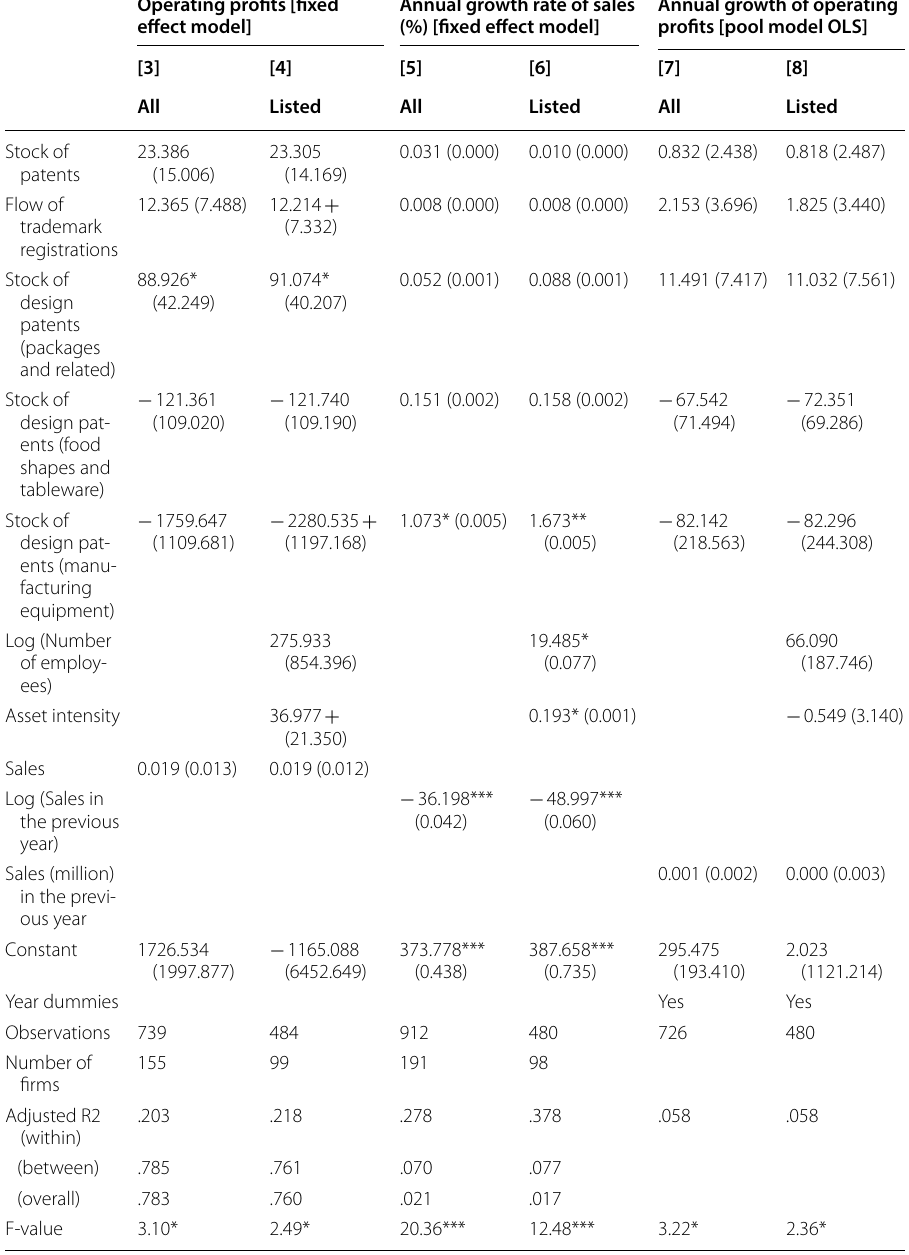
Table 4 Regression results of operating profits, growth of sales, and operating profits (IPRs’